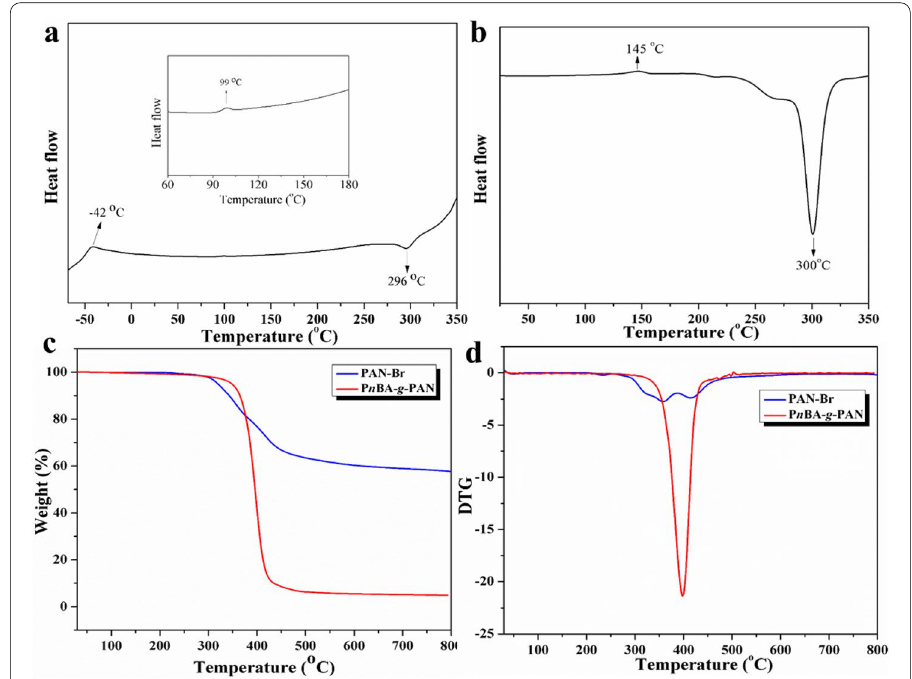
Fig. 2 DSC traces of a P n BA- g -PAN graft copolymer and b PAN-Br; c TGA curves and d DTG curves of PAN-Br and P n BA- g